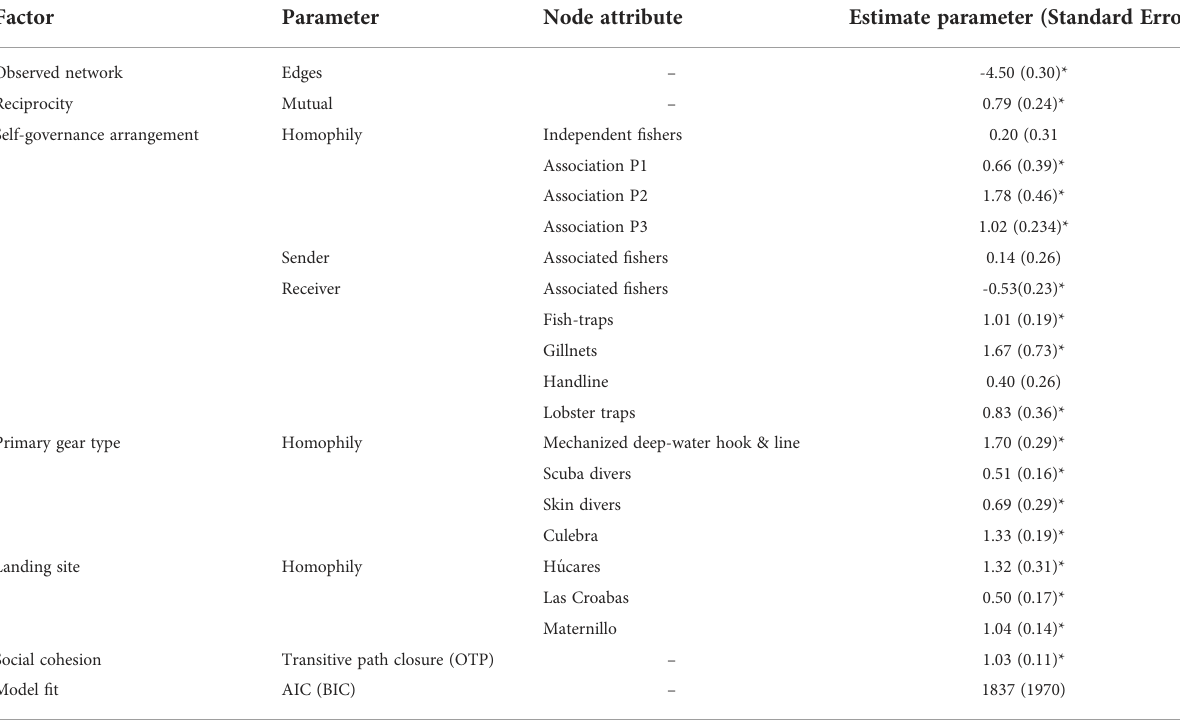
TABLE 5 Results from the best- fi tting nested exponential random graph model for the information-sharing network among commercial fi shers.